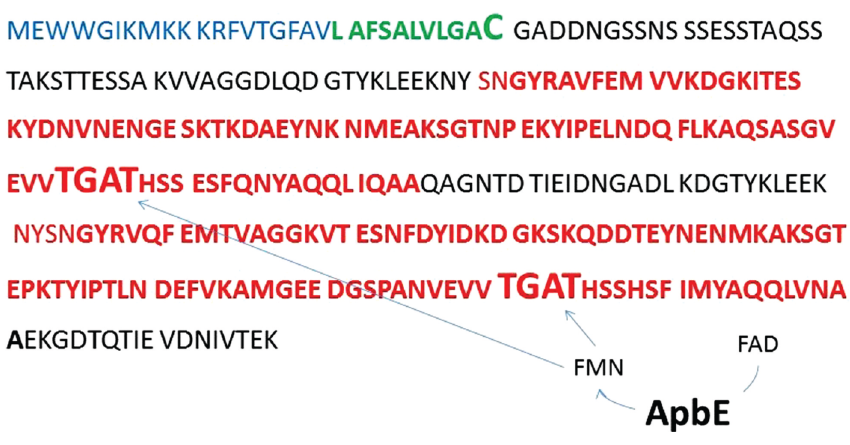
Figure 7: ApbE specific binding motifs for FMN insertion in cAD1 (P13268) sex pheromone protein precursor (SEED ID: